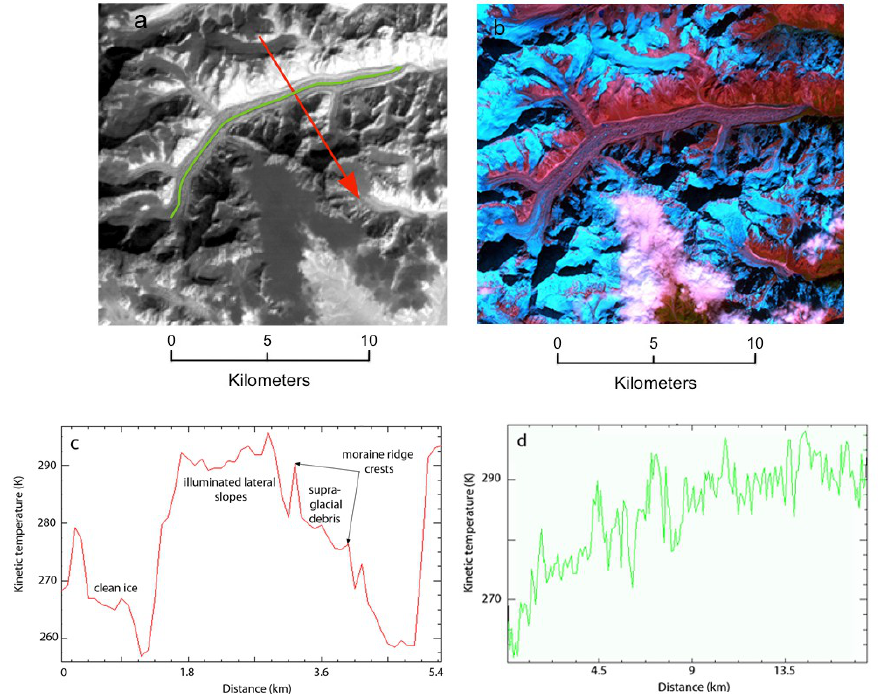
Figure 6. ( a ) AST08 product (kinetic temperature band) for Zemu glacier, with two transects: across the Zemu glacier and surroundings (transect #1, in red) and along the glacier (transect #2, in green); ( b ) ASTER color composite 432 shown for comparison; ( c ) surface temperature across Zemu and surrounding surfaces (direction NW to SE); on the lower left graph, we point to the sharp lateral moraine ridge crests visible on as bright pixels on the surface temperature image; ( d ) surface temperature along the tongue of Zemu glacier (direction SW to NE). Surface temperature generally increases towards the glacier terminus, indicating a thicker debris